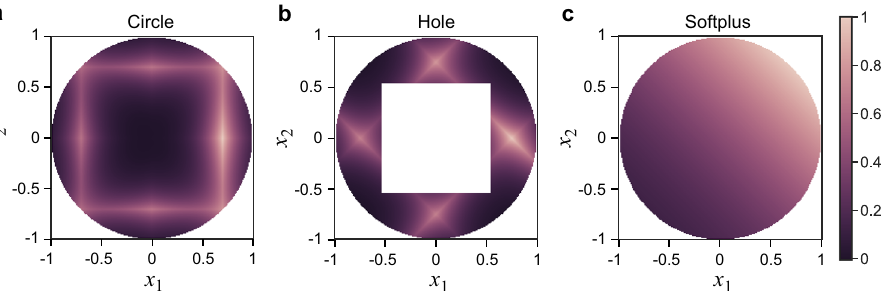
Fig. 1 Visualization of functions used in the simulated experiments. Search spaces are two-dimensional [ − 1,1] boxes for the Circle ( a ), Hole ( b ) and Softplus ( c ) functions. White areas indicate experimental failure